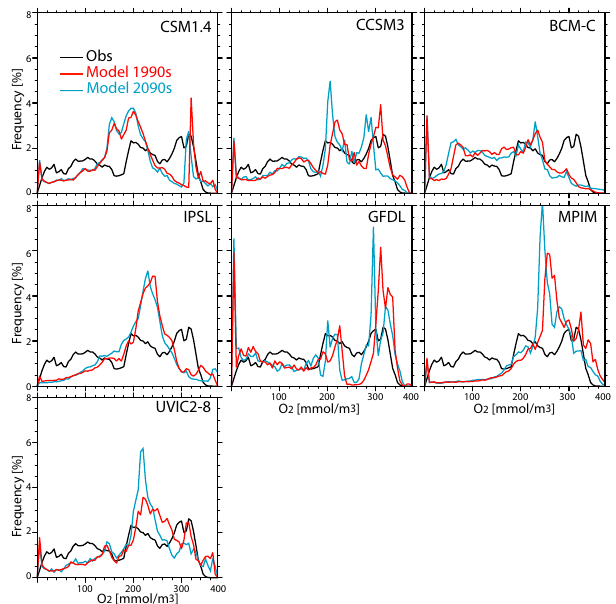
Fig. 2. O 2 frequency distribution in the UML (from 100 to 600m depth), obtained by sampling the volume fraction that falls within 20mmolm − 3 intervals. Black line: observation-based distribution (from GLODAP and WOA 09 gridded data). Red: 1990s mod- eled distribution (decadal mean). Blue: 2090s modeled distribution (decadal